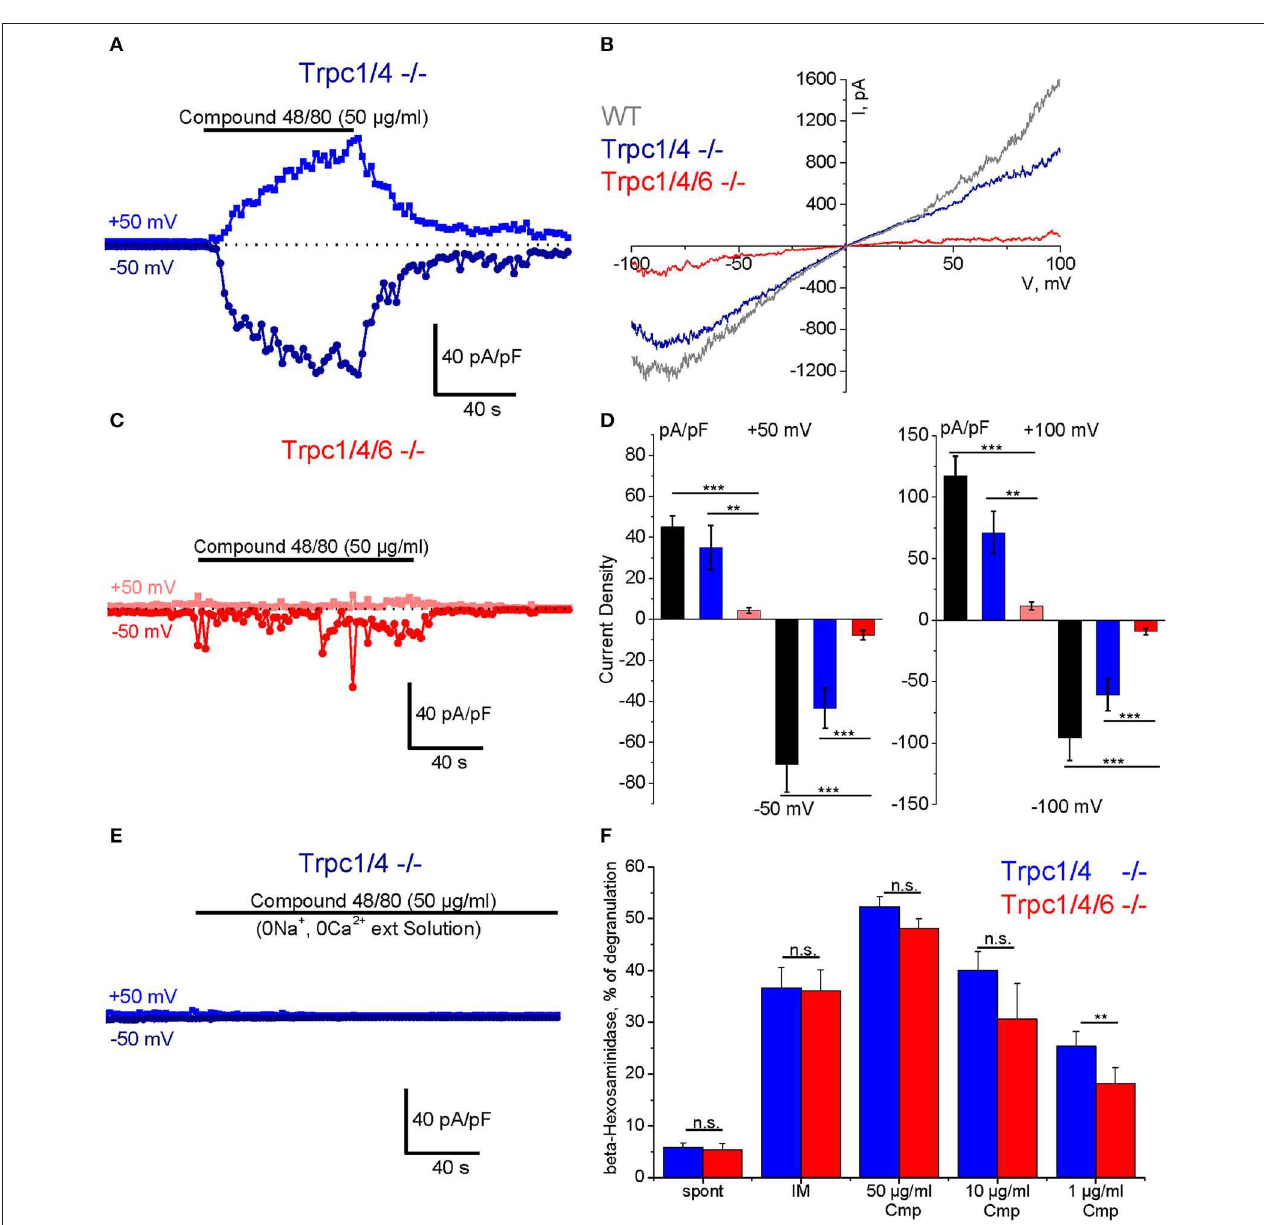
FIGURE 5 | Compound 48/80-induced whole-cell transmembrane currents (A–E) and degranulation (F) in PMC isolated from TRPC-deficient mice. (A) Representative time course of the amplitude of inward (dark blue) and outward (blue) currents measured at − 50 and + 50mV, respectively in PMC isolated from Trpc1/4 − / − (DKO) mice (DKO, genotype Trpc1/4 − / − ; Trpc6 + / + ). The currents were elicited by acute application of Compound 48/80 (50 µ g/ml) as indicated by horizontal bar. (C) Representative time course of the amplitude of inward (red) and outward (pink) currents measured at − 50 and + 50mV, respectively in PMC isolated from Trpc1/4/6 − / − (TKO) mice. The currents were elicited by acute application of Compound 48/80 (50 µ g/ml) as indicated by horizontal bar. Current amplitude is normalized to the cell capacitance and presented as pA/pF. (B) Representative current-voltage relationship curves measured in PMC isolated from wild type (WT, gray), Trpc1/4 − / − (DKO, genotype Trpc1/4 − / − ; Trpc6 + / + , blue) and from Trpc1/4/6 − / − (TKO) mice (red). The curves correspond to the measurements presented in (A,C) at the current’s maximal values. (D) Statistical bar diagrams of the maximal current density measured at + 50/ − 50mV (left panel) and at + 100/ − 100mV (right panel) shows the mean (vertical bars) and S.E.M. (error bars) values calculated for PMC isolated from WT (gray and black bars) Trpc1/4 double deficient (blue and dark blue) and Trpc1/4/6 deficient (pink and red bars) mice. The measurements were performed with PMC originating from three independent preparation and 15–20 individual cells were analyzed. Horizontal bars indicate significance (** p < 0.01 and *** p < 0.001). (E) Representative time course of the amplitude of inward (dark blue) and outward (blue) currents measured at − 50 and + 50mV, respectively in PMC isolated from Trpc1/4 − / − (DKO) mice. Compound 48/80 was applied in Ca 2 + - and Na + -free external solution in concentration 50 µ g/ml as indicated by horizontal bar. (F) Degranulation of PMC measured using ß-hexosaminidase release assay and presented as % of degranulation. PMC were isolated from Trpc1/4 − / − (DKO) mice (blue bars) and Trpc1/4/6 − / − (TKO) (red bars) mice and stimulated with different concentrations of Compound 48/80 (Cmp). Positive (IM: − 10 µ M of ionomycine) and negative controls (spont- spontaneous release) were also